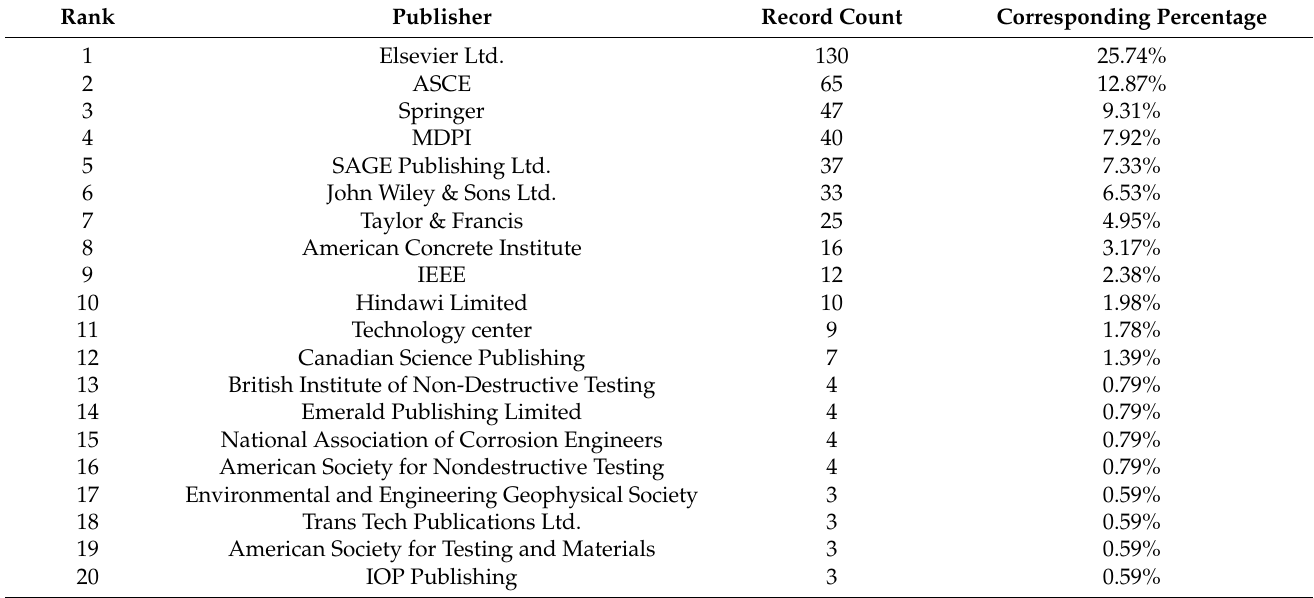
Table 4. Categorization of journal articles according to the